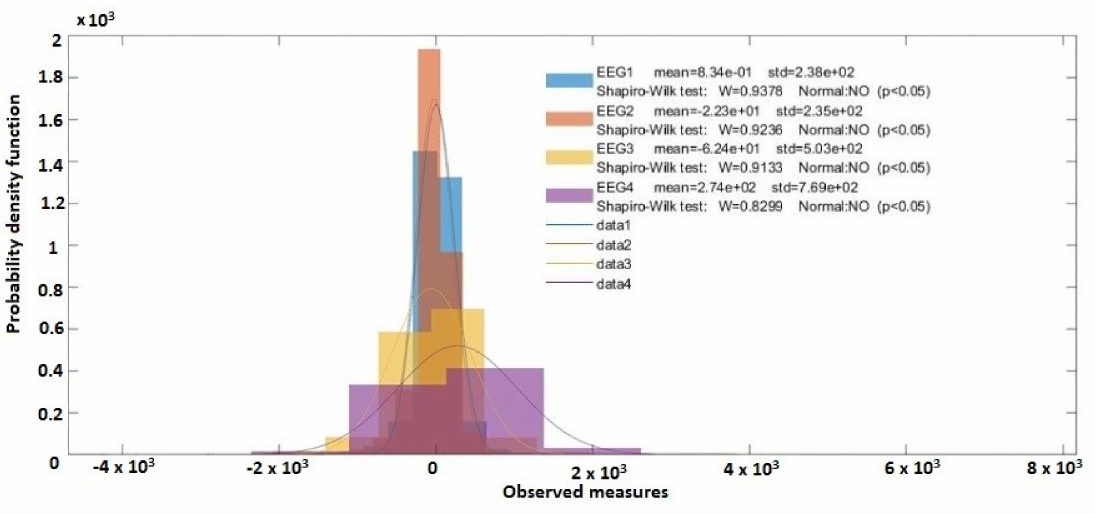
Figure 17. Distribution probabilities (Shapiro–Wilk test,